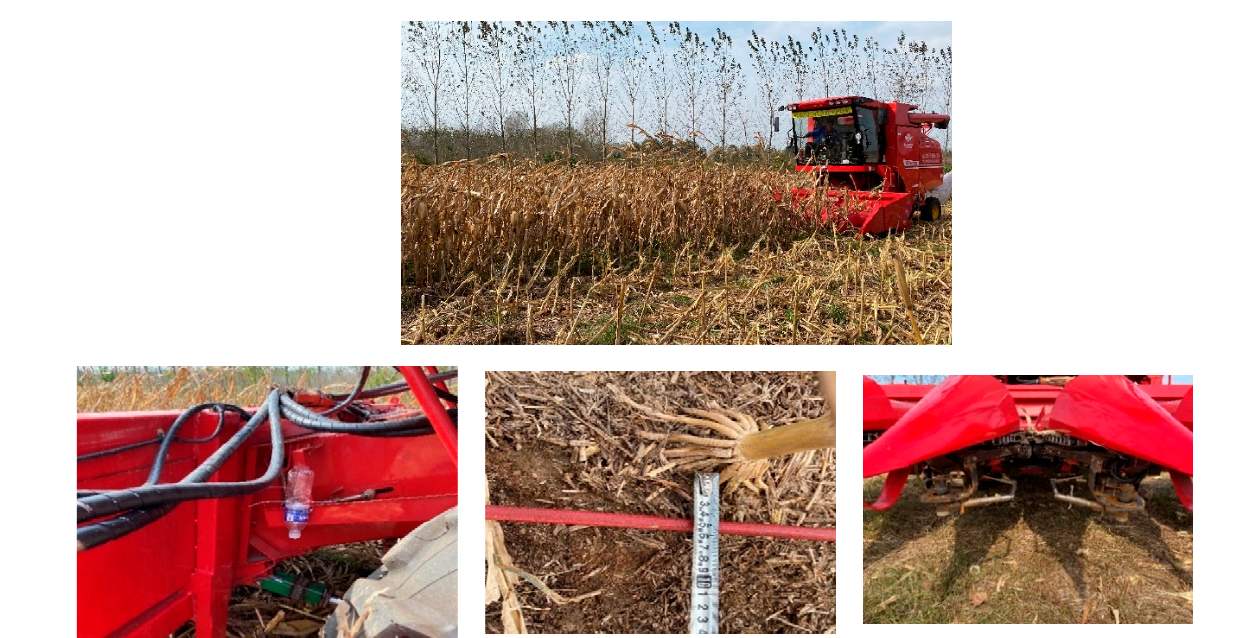
Figure 16. Test of automatic row alignment system for corn harvester.